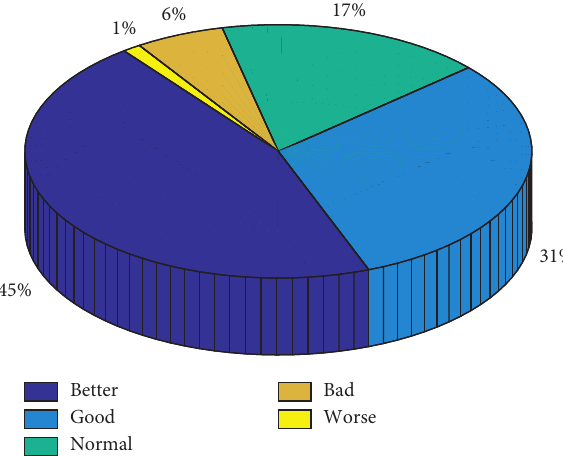
Figure 7: The recognition of the 3D model of multivisual ani- mation characters based on VR